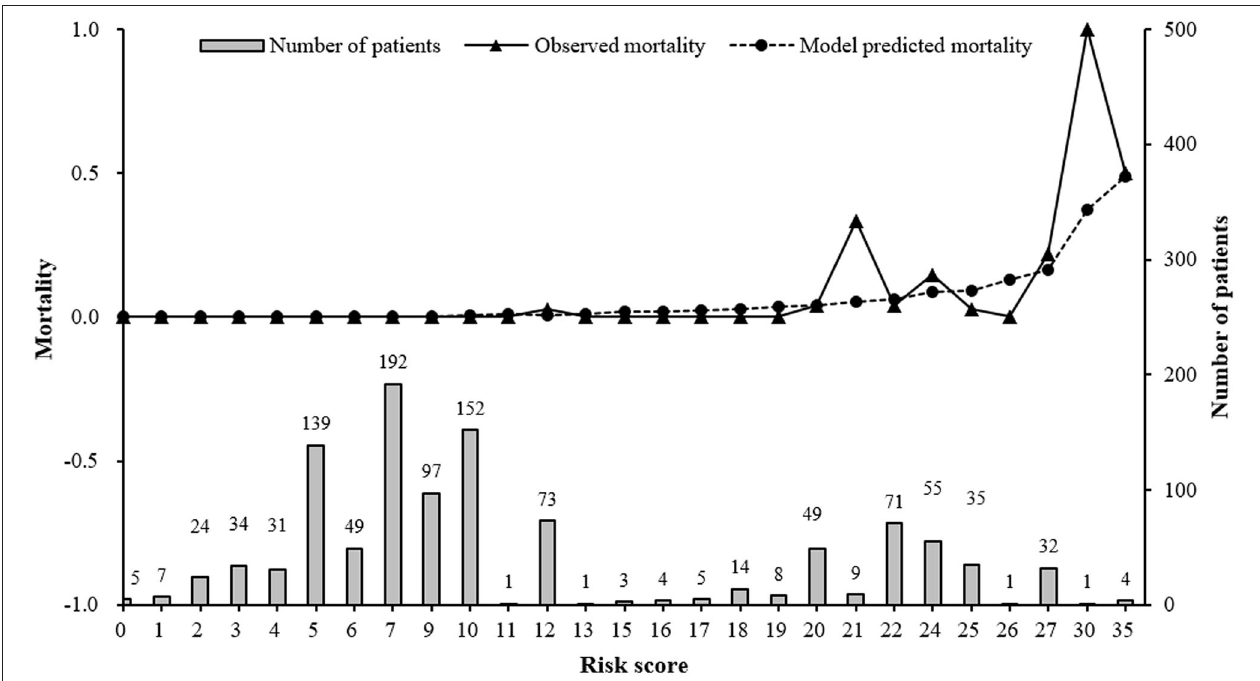
FIGURE 3 | Observed, predicted in-hospital mortality along with risk score and distribution of risk score in AECOPD patients between 2015 and 2017. Model predicted mortality was calculated using our final prediction model: Log(mortality/(1-mortality)) = − 9.1935 + 0.0418*age + 3.0752*Respiratory failure + 1.7674*Pneumothorax + 0.0243*Length of stay Risk score was the total risk points, which was the sum of each predictor’s risk point based on individual